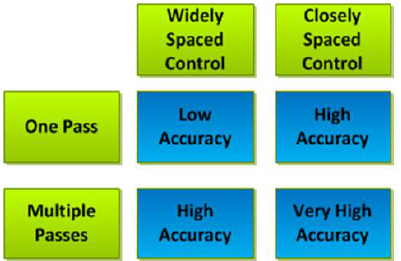
Figure 4. Truth Table - Multipass vs Control Spacing